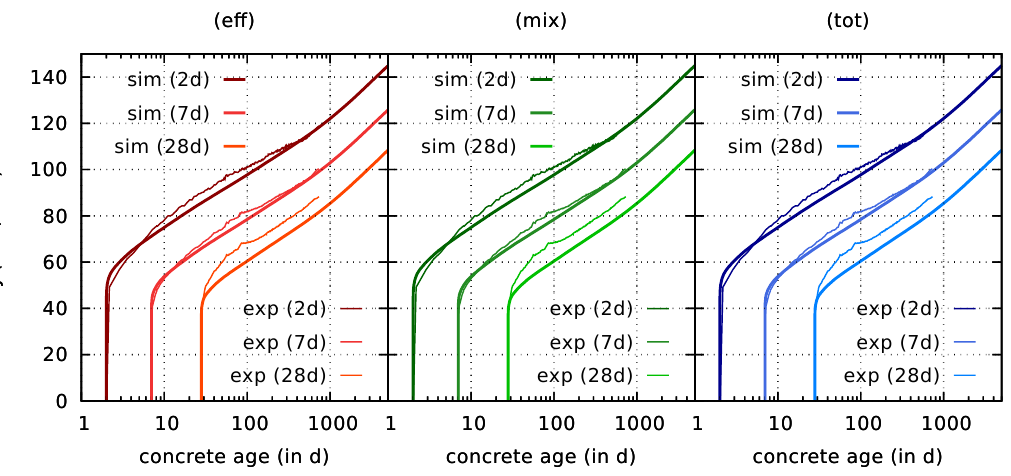
Figure 6. Computed (sim) and measured [8,9] (exp) creep compliance functions for sealed cylinders loaded at concrete ages of 2 days, 7 days, and 28 days, respectively, based on the effective stress formulation (eff), the mixed stress formulation (mix), and the total stress formulation